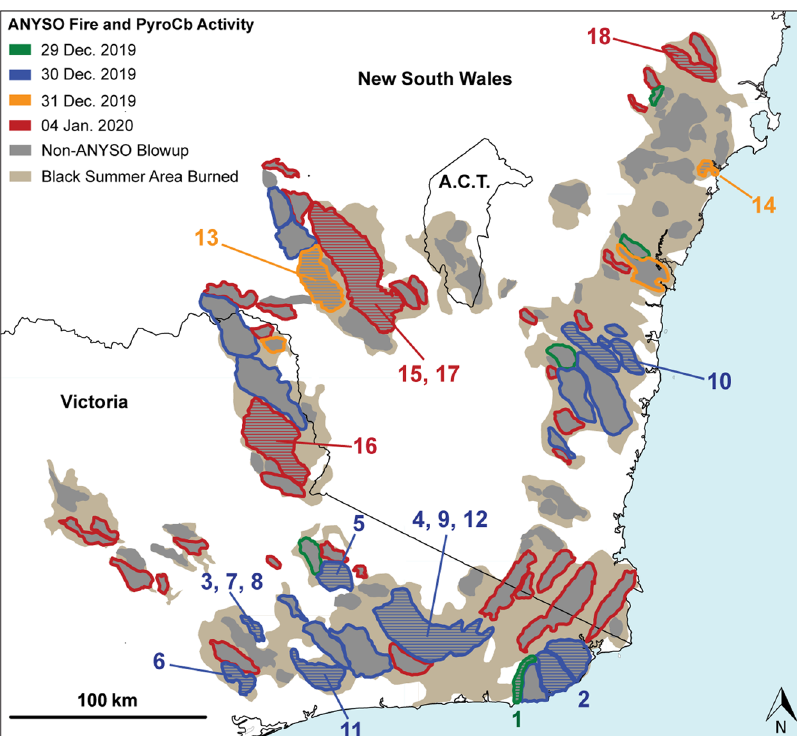
Fig. 1 Map of the blow-up fi res contributing to ANYSO pyroCb activity. Light brown shading shows the full area burned during the ‘ Black Summer ’ fi re season of 2019 – 2020, with 109 individual blow-up fi res superimposed in dark grey. Perimeters of blow-up fi res during the ANYSO period are color-coded by date. Hatching in the same color scheme identi fi es the 13 blow-up fi res that contributed to pyroCb development. Numbers identify the approximate initiation points of 18 pyroCb sub-events, corresponding with the ANYSO timeline in Fig.